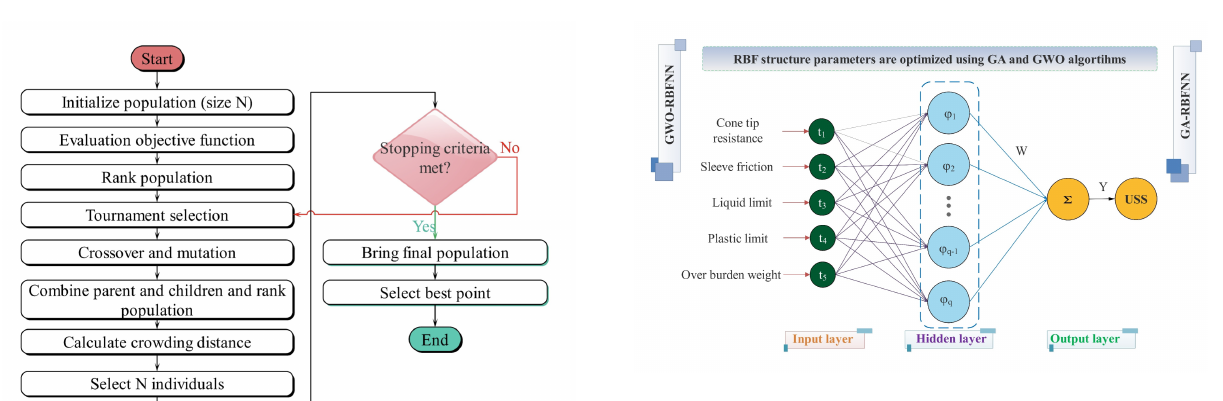
Fig. 6. Radial basis function structure ron number. Determining parameters in the efficiency of RBFNN is defining the best combination of neuron num- bers and spread rate. The integrated GWO-RBFNN